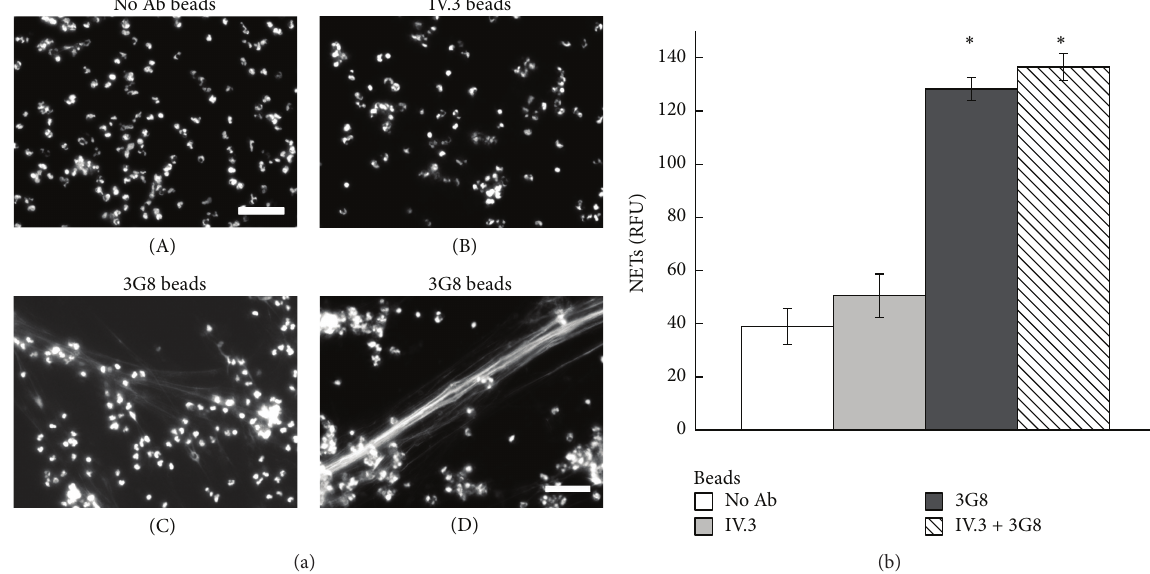
Figure11:Anti-Fc 𝛾 RIIIb-opsonizedparticlesinduceNETformation.(a)Humanneutrophils(PMN)mixedwithlatexparticlesnonopsonized (no Ab beads) or opsonized with monoclonal antibody IV.3, anti-Fc 𝛾 RIIa (IV.3 beads), or with monoclonal antibody 3G8, anti-Fc 𝛾 RIIIb (3G8 beads), were incubated for four hours and fixed and stained for DNA (DAPI). Microphotographs were taken at 200x magnification and are representative of three experiments. Bar is 50 𝜇 m. (b) The relative amount of NETs was estimated from SYTOX Green fluorescence in relative fluorescent units (RFU) at 4 hours after stimulation, as described in Materials and Methods. Data are mean ± SEM of four experiments. Asterisks denote conditions that are statistically different from control ( 𝑝 < 0.02